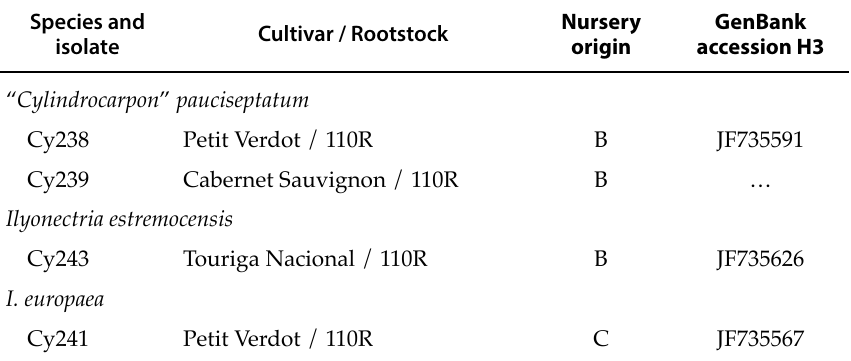
Table 1. Ilyonectria -like isolates obtained from a young vineyard showing symptoms of early decline: species identified, isolate, grapevine cultivar and rootstock, nursery origin (A and B, Portugal; C, abroad) and GenBank accession number. Species and